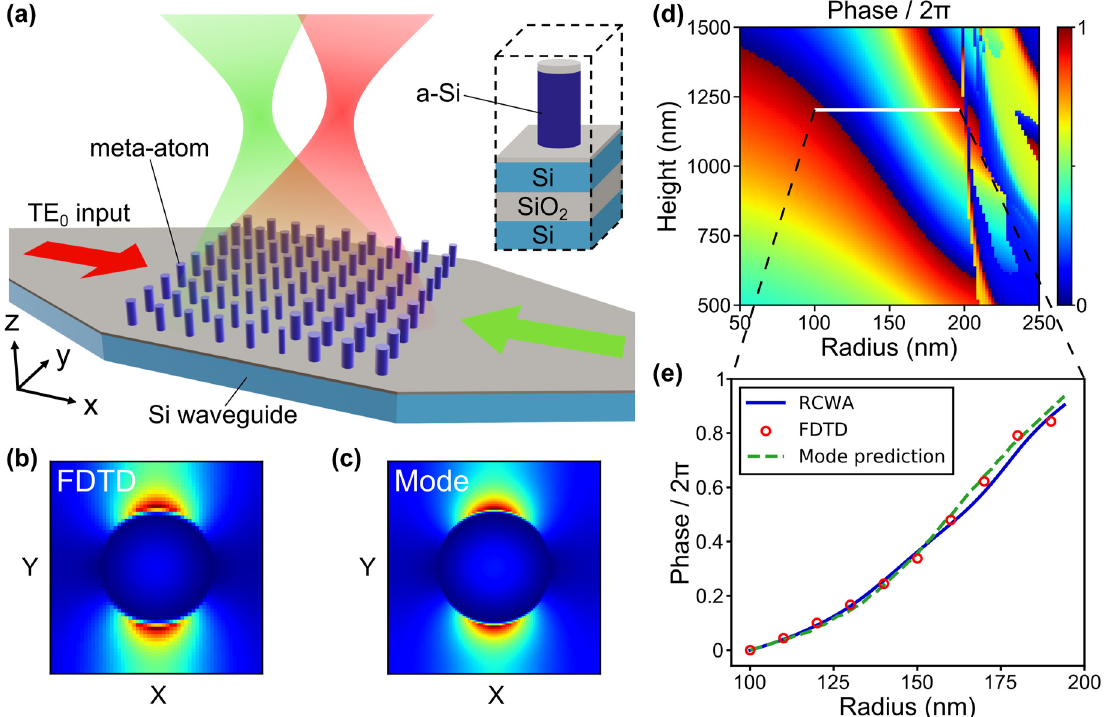
Figure 1: Schematic and simulation of the monolithic platform of metasurfaces on silicon photonics. (a) Schematic of a metasurface integrated on a silicon waveguide for switchable beam focusing. The metasurface consists of a-Si nanopillars in a square lattice. The metasurface is excited by the guided mode and creates focusing emission. The focused spot can be switched between two positions, depending on the excitation direction, as indicated by the green and red colors. Inset: schematic of the meta-atom unit cell (height: 1.2 μ m; period: 562 nm). (b) FDTD-simulated intensity distribution near one of the nanopillars in the lattice when excited by the guided mode. The nanopillar radius is 150 nm. (c) Eigenmode of a nanopillar in the lattice (nanopillar radius: 150 nm). (d) RCWA-simulated phase of the emission from the nanopillar array as a function of the nanopillar height and radius. (e) Meta-atom phase library used in the design, where the radius ranges from 100 to 194 nm. We confirm the phase response with three different simulation methods: RCWA (blue solid line), 3D FDTD (red circle), and mode prediction (green dashed line), showing the phase response originates from the propagation phase delay in each